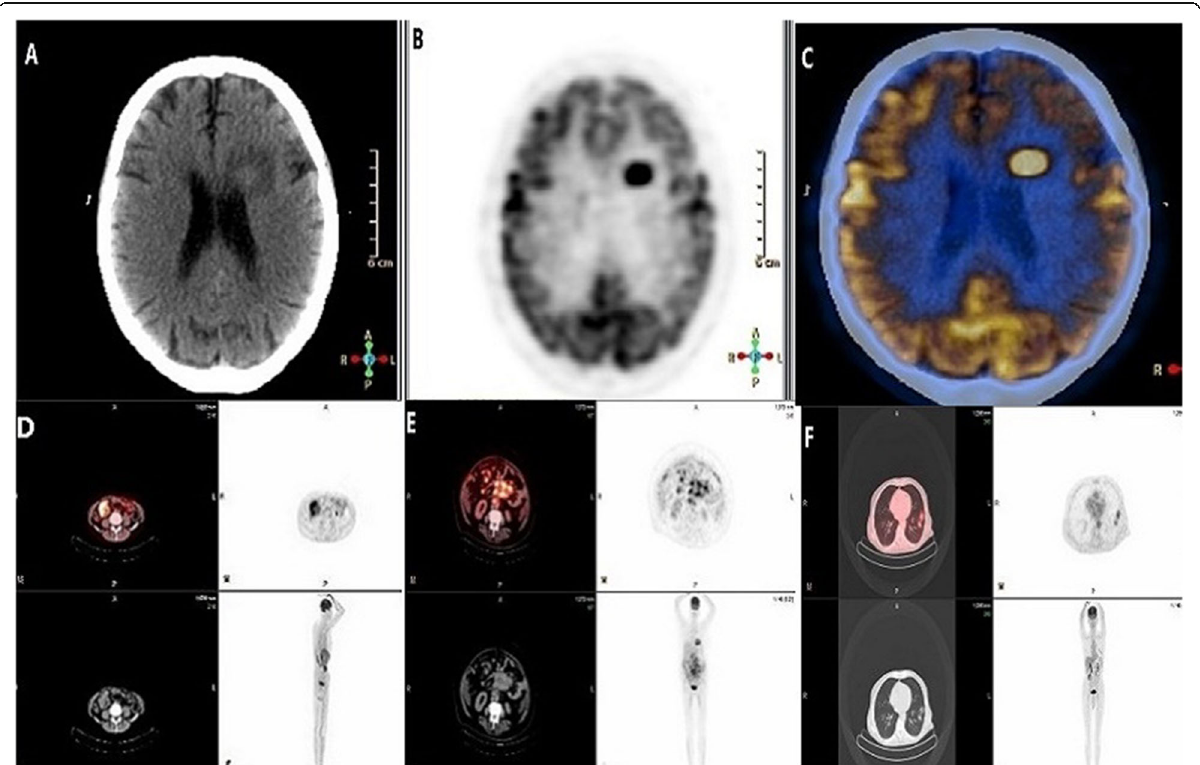
Fig. 6 A 64-year-old patient with single metastatic mass lesion in left posterior frontal lobe. a – c Axial CT, PET, and fused PET/CT scan showed active solitary metastatic lesion seen in the left posterior frontal lobe. d Multiplanar fused PET/CT and PET scan showed a cecal mass with active uptake proved by colonscopic biopsy to be adenocarcinoma of caecum. e Multiplanar fused PET/CT and PET scan showed multiple active retroperitoneal lymph nodes. f Multiplanar fused PET/CT and PET scan showed two metastatic active mass lesions in the left